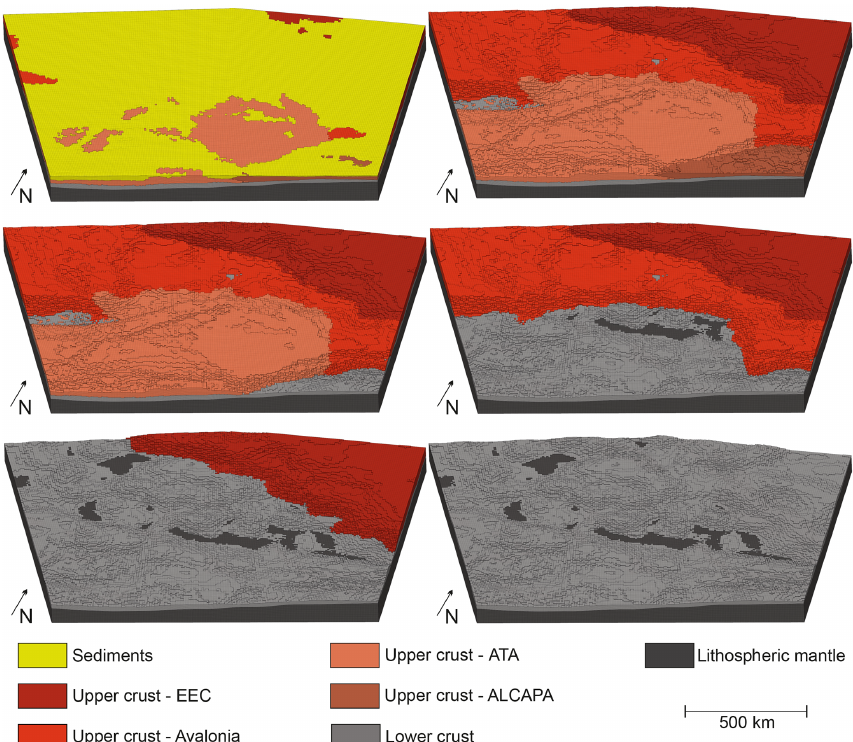
Figure 5. Six different views of the discretized model showing the internal model structure. The sedimentary unit is colored in yellow, the upper crust in different red shades regarding to different tectonic units (Fig. 1c), the lower crust in light grey and the lithospheric mantle in dark grey. The dimension of the model is 1000 × 1250 × 100km 3 comprising 1.32 million hexahedral elements. ALCAPA –